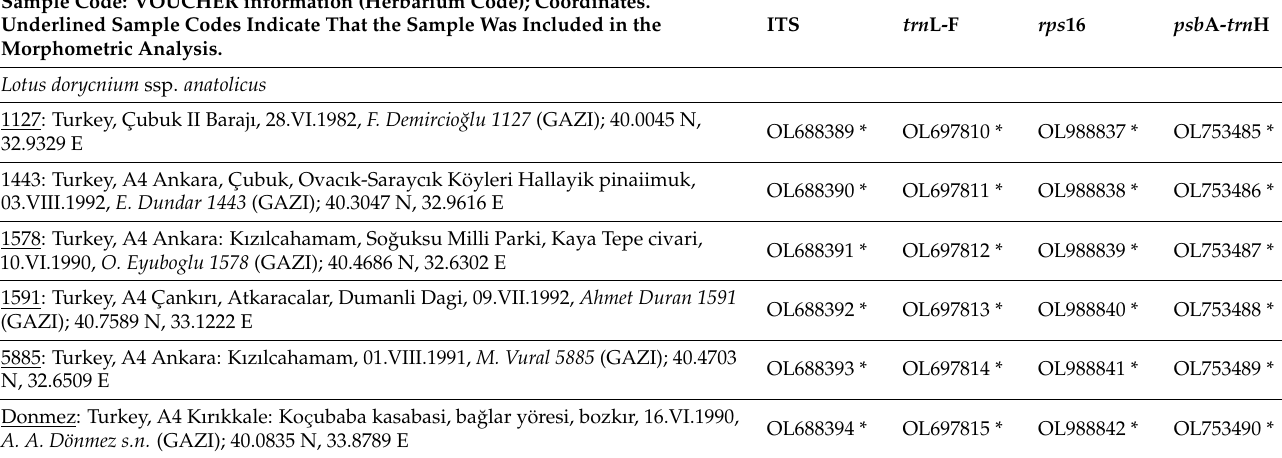
Table 2. Taxa, sample code, voucher information, and GenBank accession numbers of Lotus dorycnium complex specimens used in molecular and morphological analyses. Herbarium codes according to Index Herbariorum. New sequences indicated by an asterisk (GenBank accession numbers for rps16 will be added to the final version of the